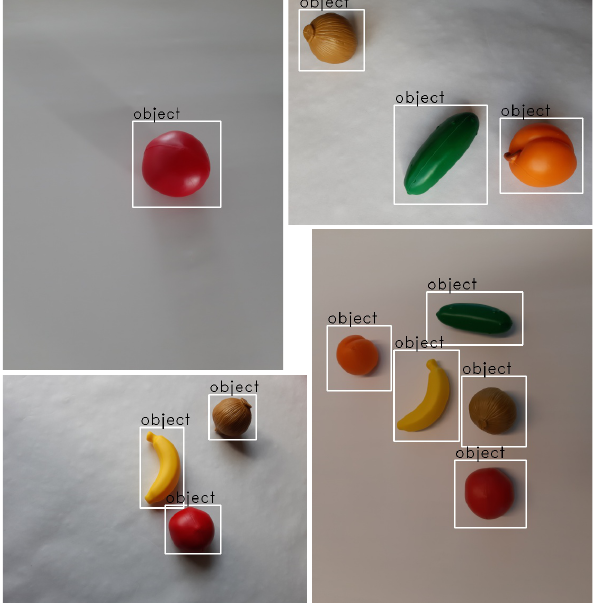
Figure 5. Annotation examples from our fruits dataset. Annotations have been generated manually using LabelImg. A piece of paper serves as background; however, the lighting differs and often induces shadows. Figure reused from our recent work